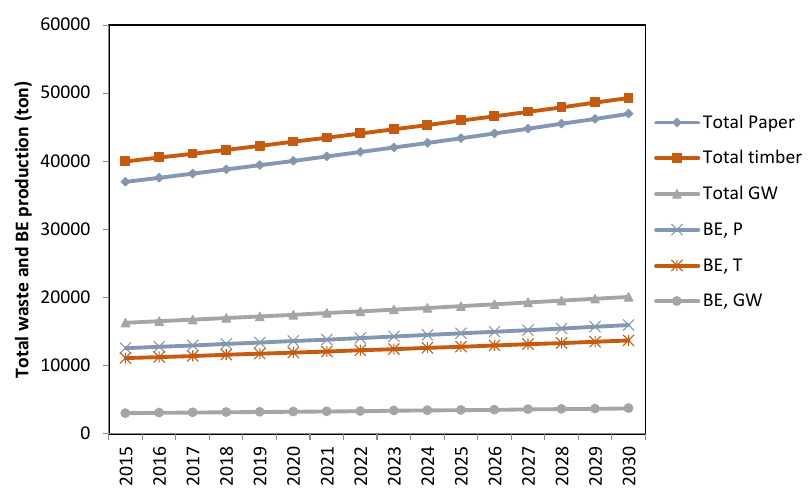
Figure 8. Total amount of various wastes and bioethanol production between 2015 and 2030.